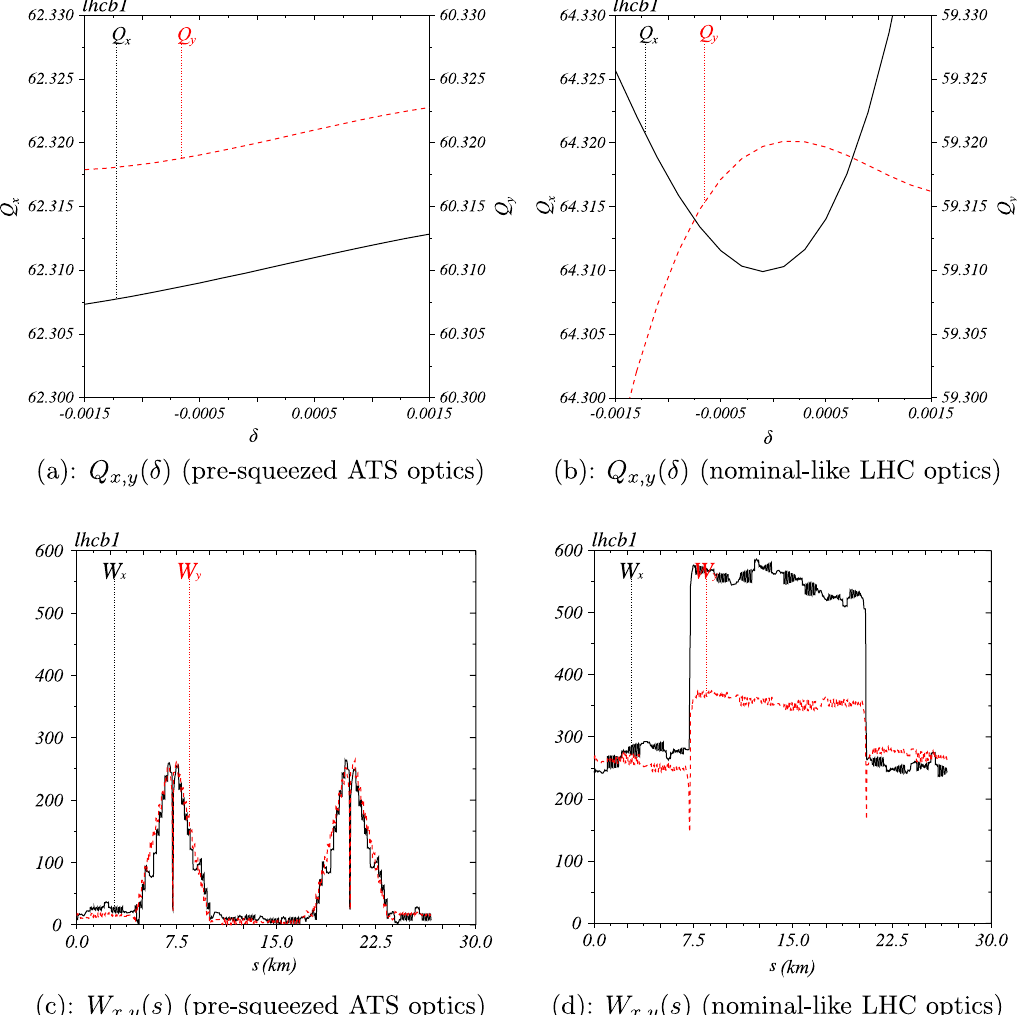
FIG. 6. Chromatic variations of the betatron tunes (top) and Montague functions (bottom) along the LHC ring (cycled from IP3). The left pictures stand for an ATS optics presqueezed down to (cid:1) (cid:1) ¼ 36 cm at IP1 and IP5 (see case 2 of Table I), which is compared to a nominal-like LHC collision optics with (cid:1) (cid:1) ¼ 35 cm (right